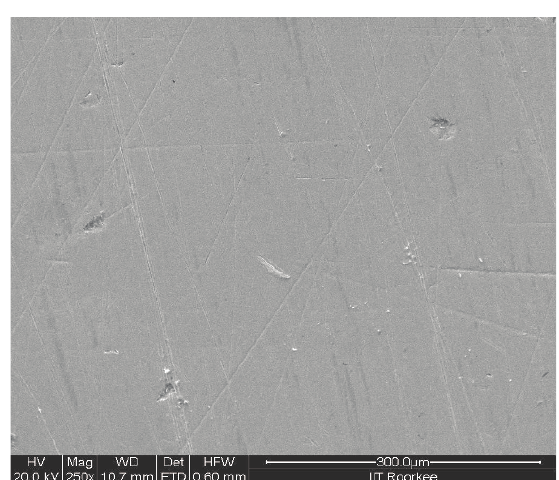
Figure 7. Scanning electron micrograph of stainless steel 304L after 50 days immersion test in Baar’s Media (Control).